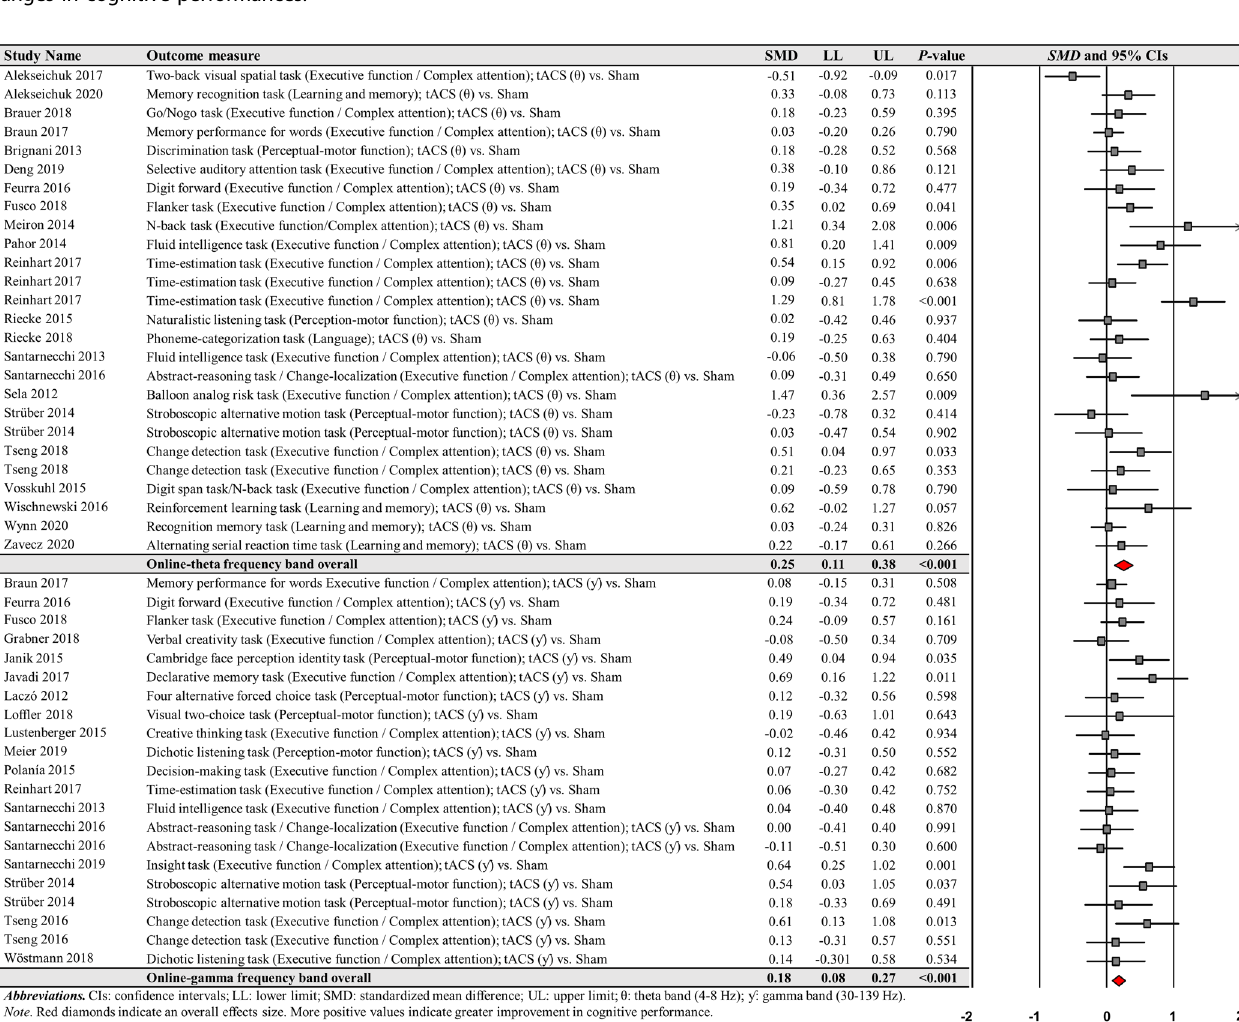
Fig. 4 Cognitive performance comparisons after of fl ine-tACS. Meta-analytic fi ndings show potential effects of of fl ine-tACS protocols on changes in cognitive performances.